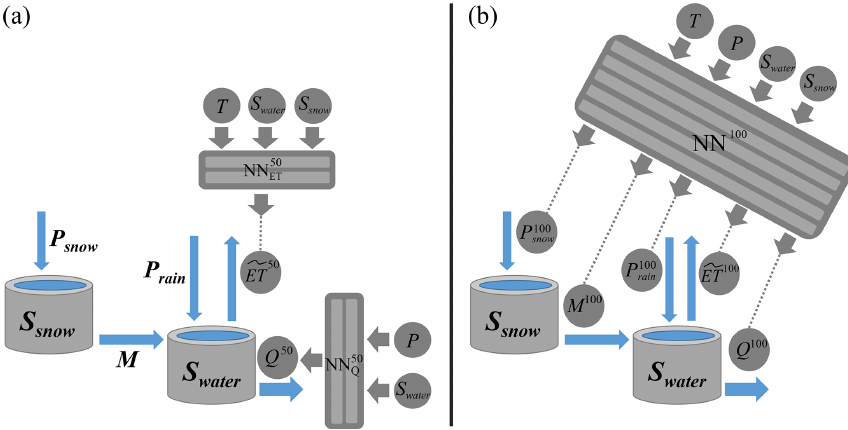
Figure 1. Schemes of the neural ODE models M50 (a) and M100 (b) : (a) the two small neural networks in M50 that substitute evapotranspi- ration (NN 50 ) and discharge (NN 50 ) have only one output node, and each has an additional input variable compared to the basic mechanistic ET Q process. (b) The large neural network (NN 100 ) has five output nodes – one for each substituted process – and all driving forces and model states as input. The structure of two model states and five processes without neural networks resembles the plain conceptual model